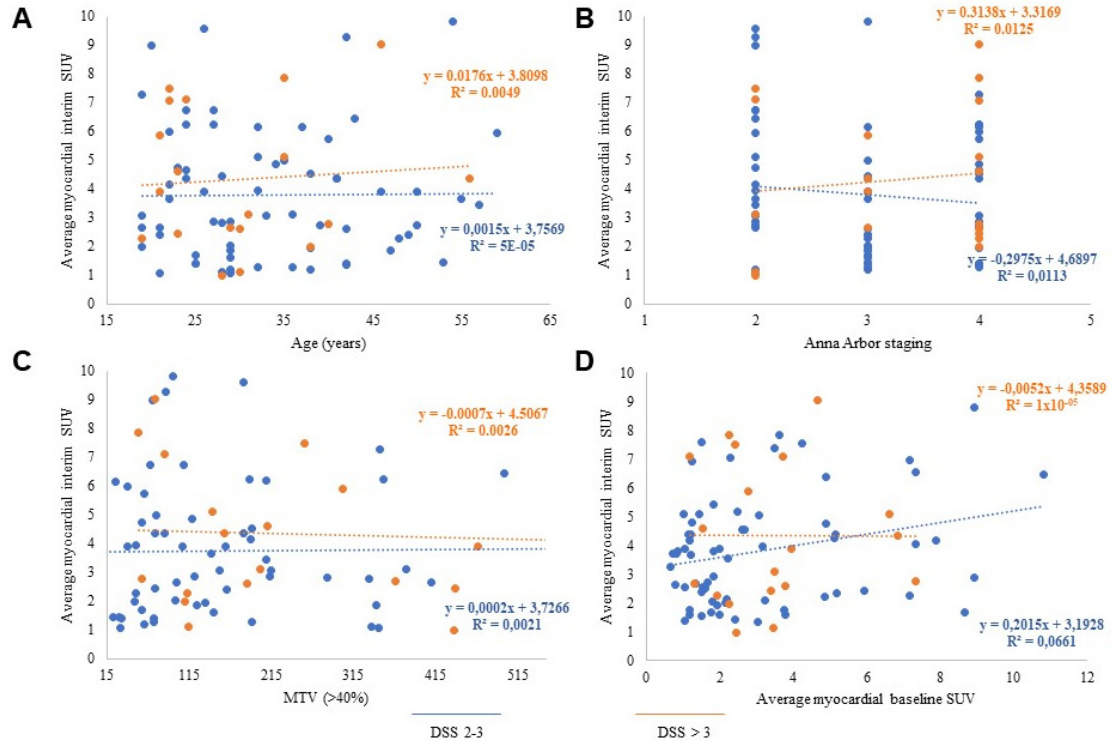
Figure 2. Average cardiac SUV at interim PET was independent of age ( A ), Ann Arbor staging at baseline ( B ), disease bulk evaluated by MTV ( C ), and the corresponding tracer retention before ABVD ( D ). The correlation was absent in both patients with DSS 2–3 (blue dots and lines) and DSS > 3 (orange dots and lines).